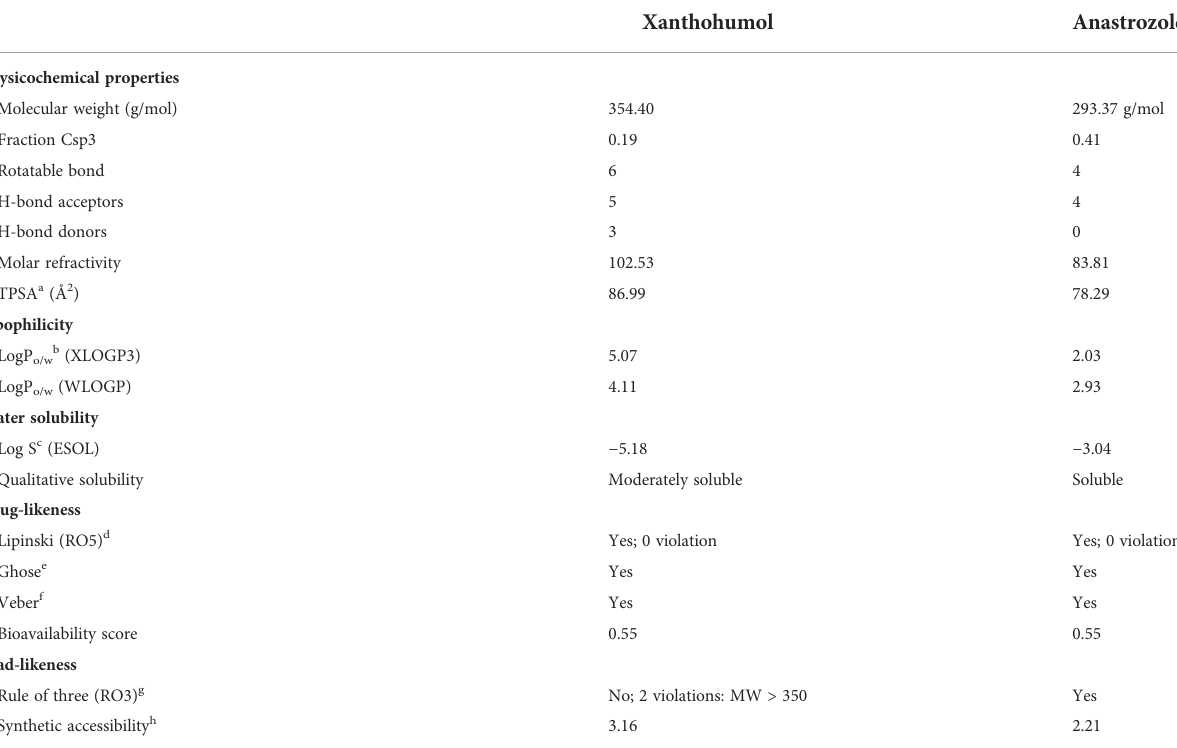
TABLE 3 ADME and drug- likeness prediction. Predictive model and their